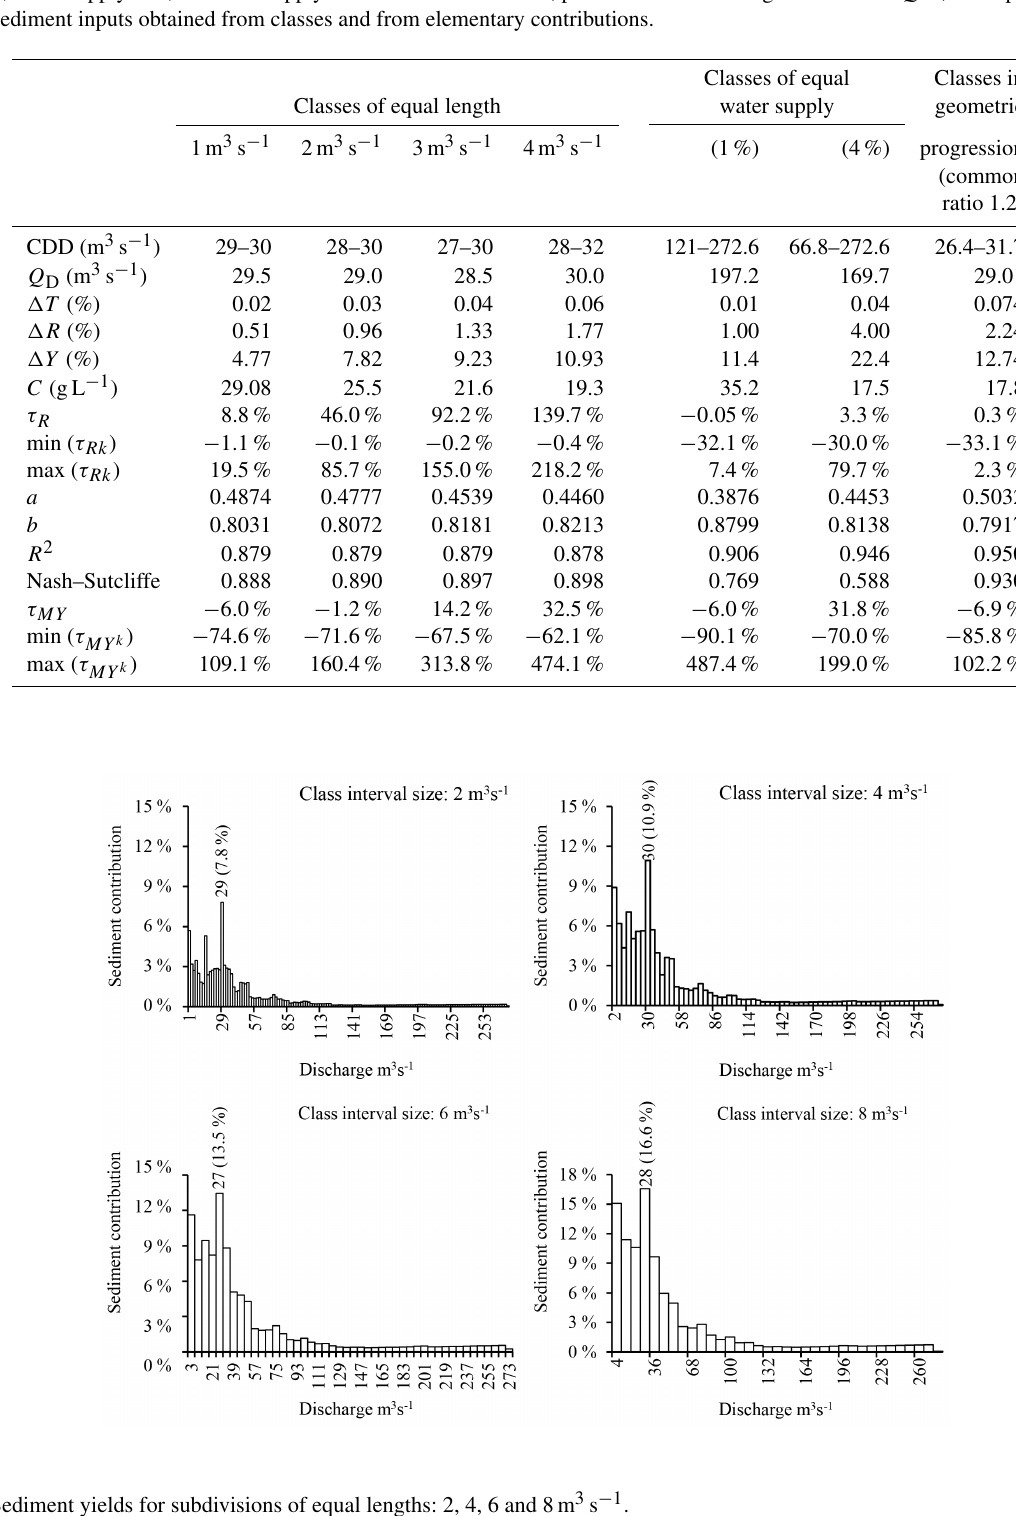
Figure 5. Sediment yields for subdivisions of equal lengths: 2, 4, 6 and 8m 3 s − 1